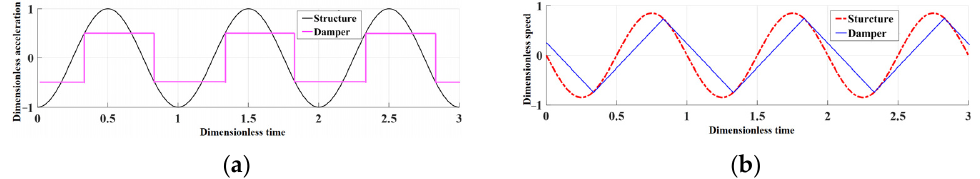
Taking θ = 0°, θ = 12° shown in Figures 5, 8 and 9, the changes of acceleration and velocity of structure and ring with time in stick–slip state ( k = 0.5) are shown. In a vibration cycle, it is no longer alternating between stick and slip stage, but always in slip stage.